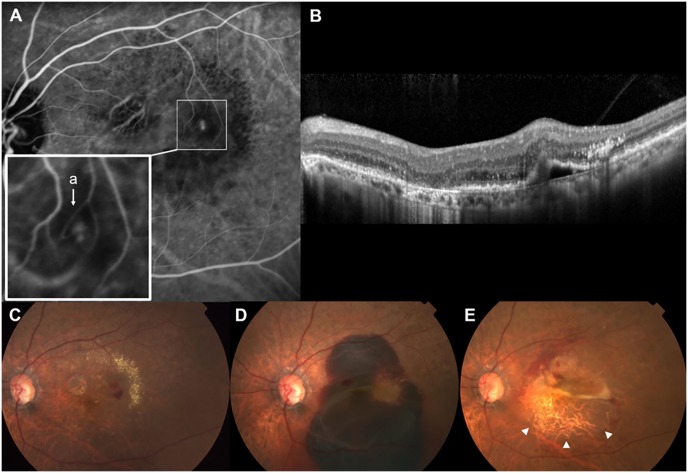
Development of a retinal pigment epithelium (RPE) tear after massive subretinal hemorrhage (SRH) in Patient 3, a 76-year-old woman with retinal angiomatous proliferation (RAP).(A) Mid-to-late phase indocyanine green angiography (ICGA) at baseline revealed a small hot-spot lesion. Inset: Early phase ICGA showing a vascular anastomosis involving retinal arteriole (a). (B) Spectral-domain optical coherence tomography through the lesion demonstrated intraretinal hyperreflective lesion with pigment epithelium detachment. (C) Color fundus photograph at baseline showing retinal hemorrhage and exudate deposition around the hot-spot lesion on ICGA. (D) Massive SRH developed 12 months after the baseline. The patient received a single bevacizumab injection with gas/rt-PA injection. (E) Then, 2 months later, an RPE tear developed (arrowheads) and best-corrected visual acuity of the left eye decreased to counting fingers.